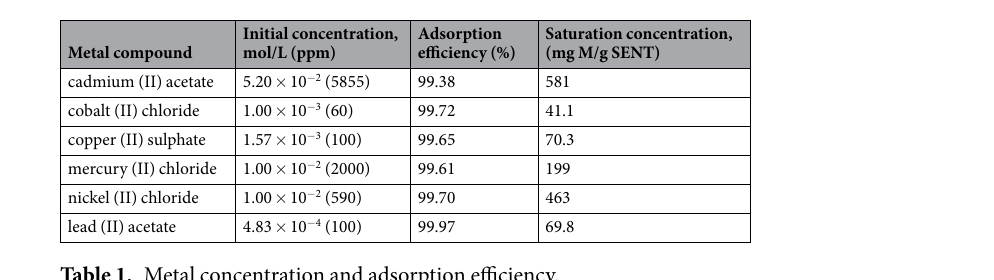
Table 1. Metal concentration and adsorption